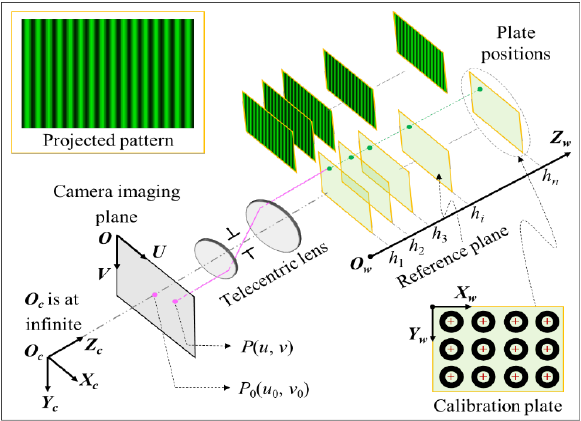
Figure 2. Schematic diagram of the proposed system calibration method.